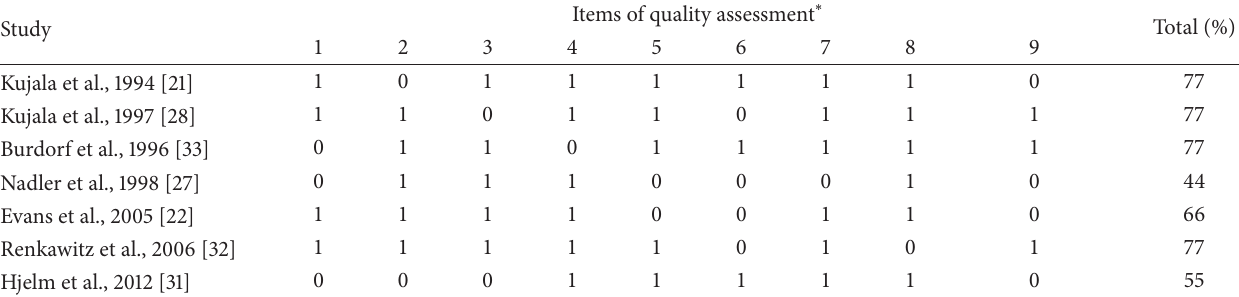
Table 3: The results of quality assessment of included